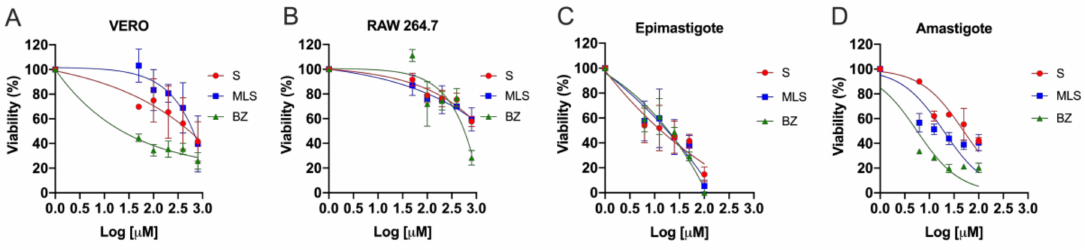
Figure 5. Cytotoxic and antiparasitic activity of BZ, S, MLV, and MLS. ( A ) VERO cells and ( B ) RAW 264.7 macrophages were treated with 50 µ M to 800 µ M of BZ, S, MLV, or MLS whereas ( C ) epimastigotes or ( D ) intracellular amastigotes were treated with 6.25 µ M to 100 µ M. Viability was analyzed by nonlinear regression in GraphPad Prism version 7.0 (GraphPad Software, San Diego, CA,